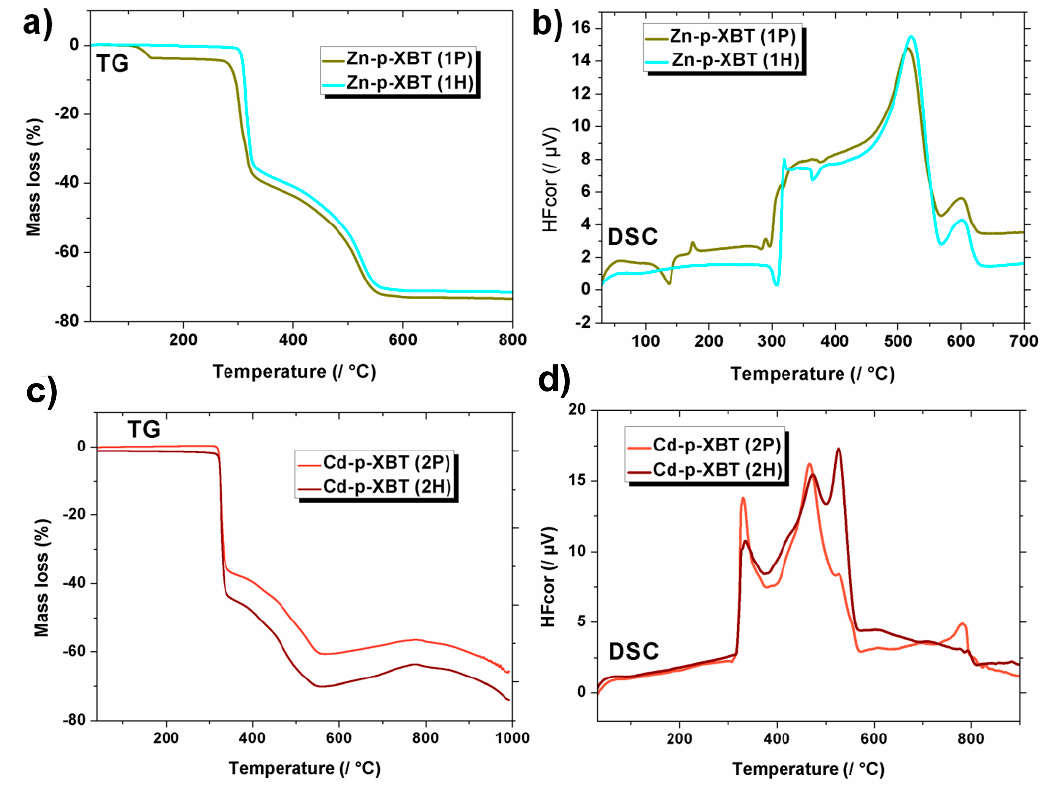
Figure 5. TG and DSC curves of 1H and 2H ( a , b ); 1P and 2P ( c , d ).